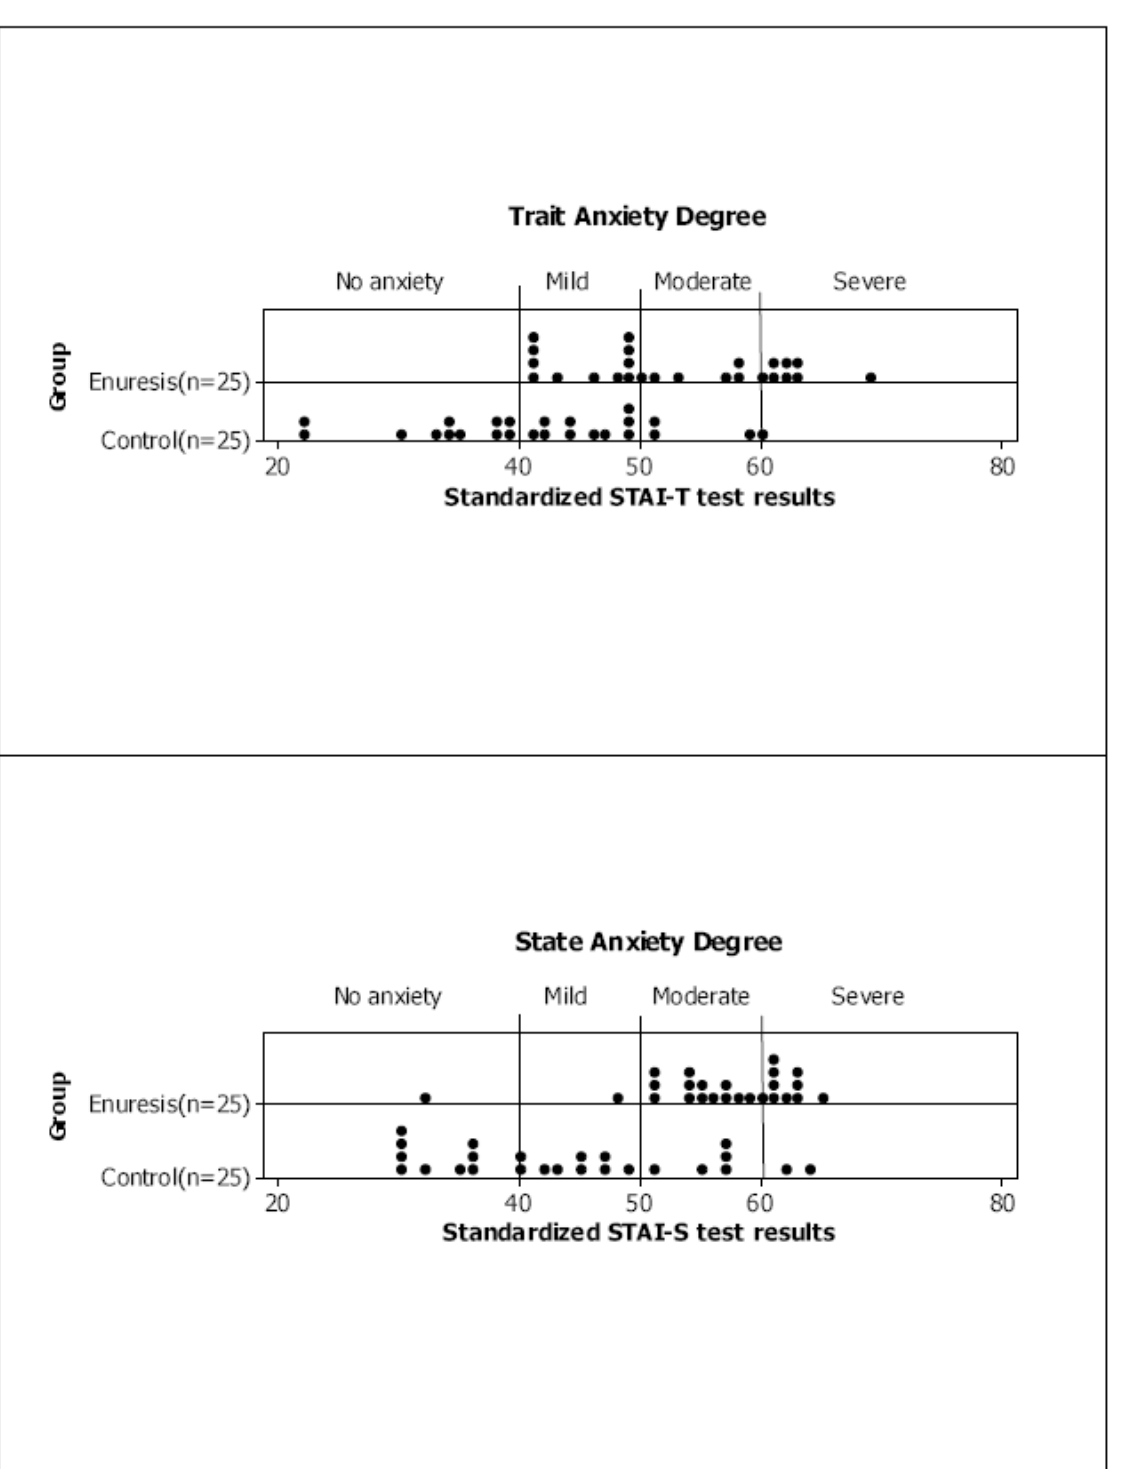
* Classification based on STAI standardized score scales.